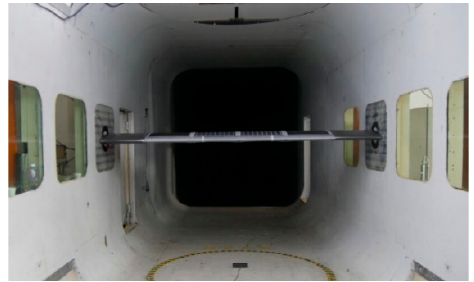
Figure 3. Experimental model in FD-09 wind tunnel.